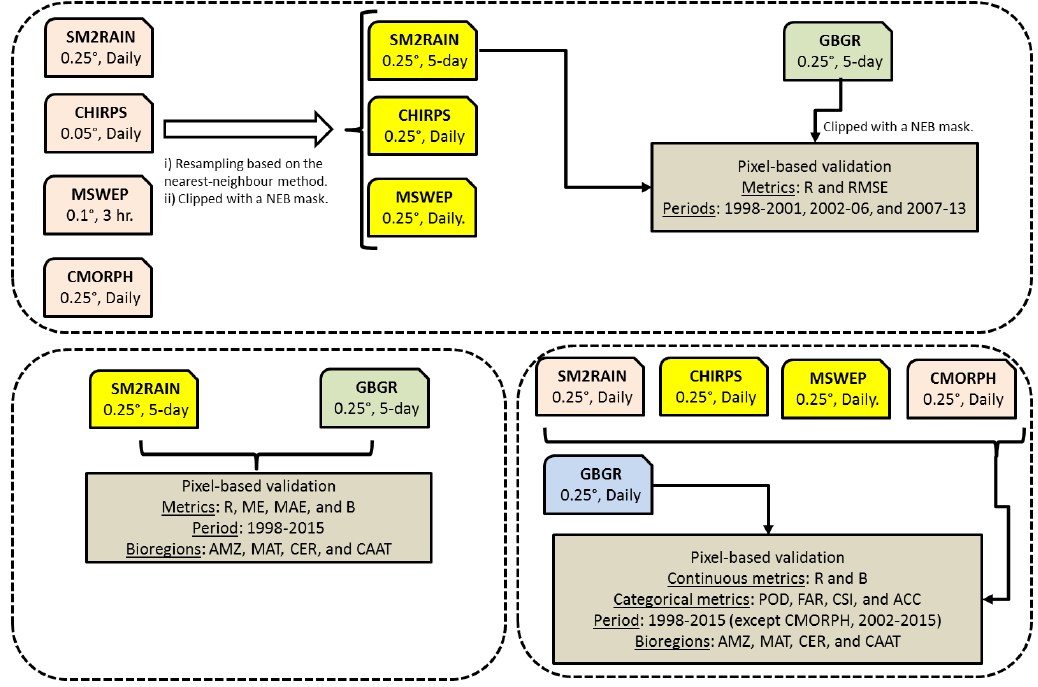
8 of 29 Table 3. Formulas of continuous metrics, where G: GBGR-based rainfall measurement, G̅ : average GBGR-based rainfall measurement, C: product-based rainfall estimate, C̅ : average product-based rainfall estimate, and N: number of data pairs. The products are SM2RAIN-CCI, CHIRPS, CMORPH, and MSWEP.